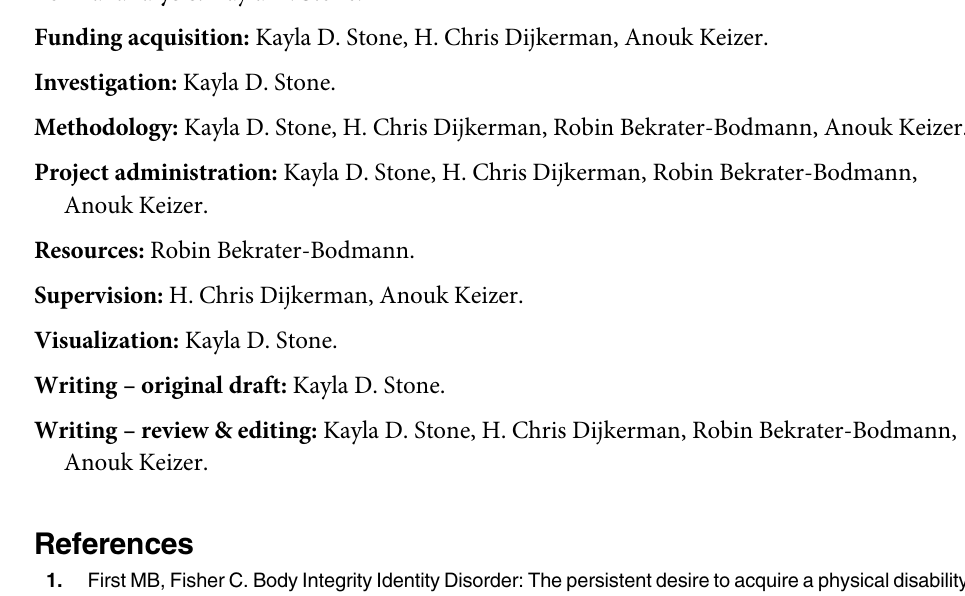
S1 Table. Characteristics of participants. General characteristics and questionnaires scores for all